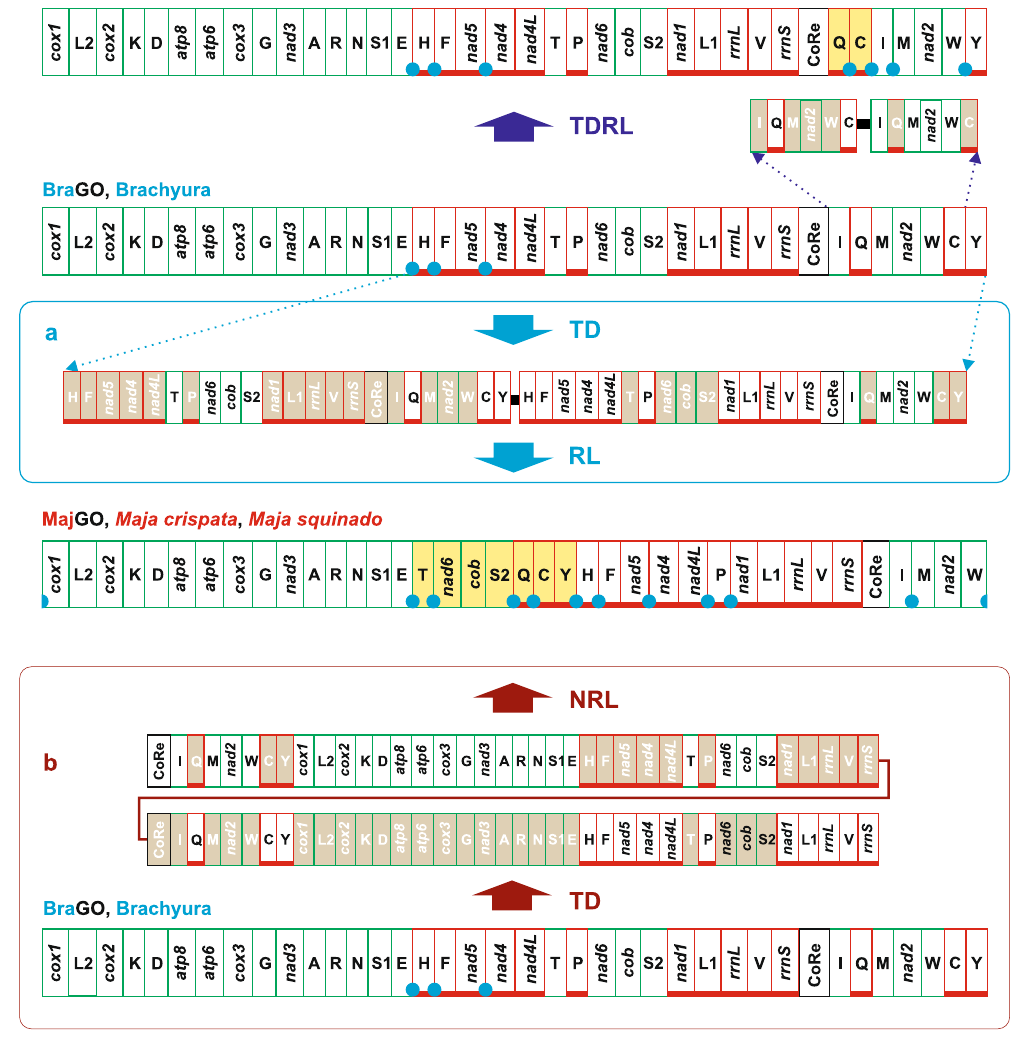
Figure 5. The evolutionary pathways generating DamGO and MajGO arrangements. The rearrangements in the GOs of D . spinosissimus and Maja species are investigated and depicted with respect to BraGO. TDRL, TD/ RL, tandem duplication/random loss event. TD/NRL tandem duplication/non random loss event. The genomic and genetic nomenclature, as well as the colour scheme, are the same as in Fig. 1. The genes that changed their position relative to PanGO, through a transposition event, are shown with a yellow background. The passively- shifted genes are figured with their original background. A blue circle marks an intergenic spacer present in a position associated to genomic